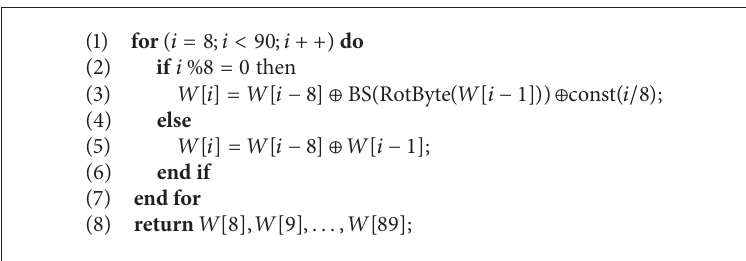
Algorithm 1: Key expansion algorithm of